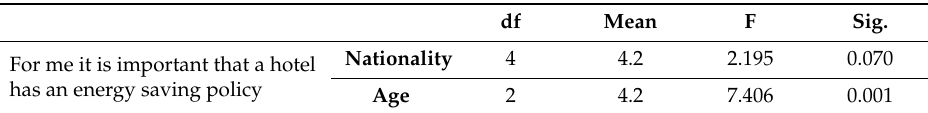
Table 9. ANOVA test comparing the importance for the hotel to have an energy-saving policy by nationality or